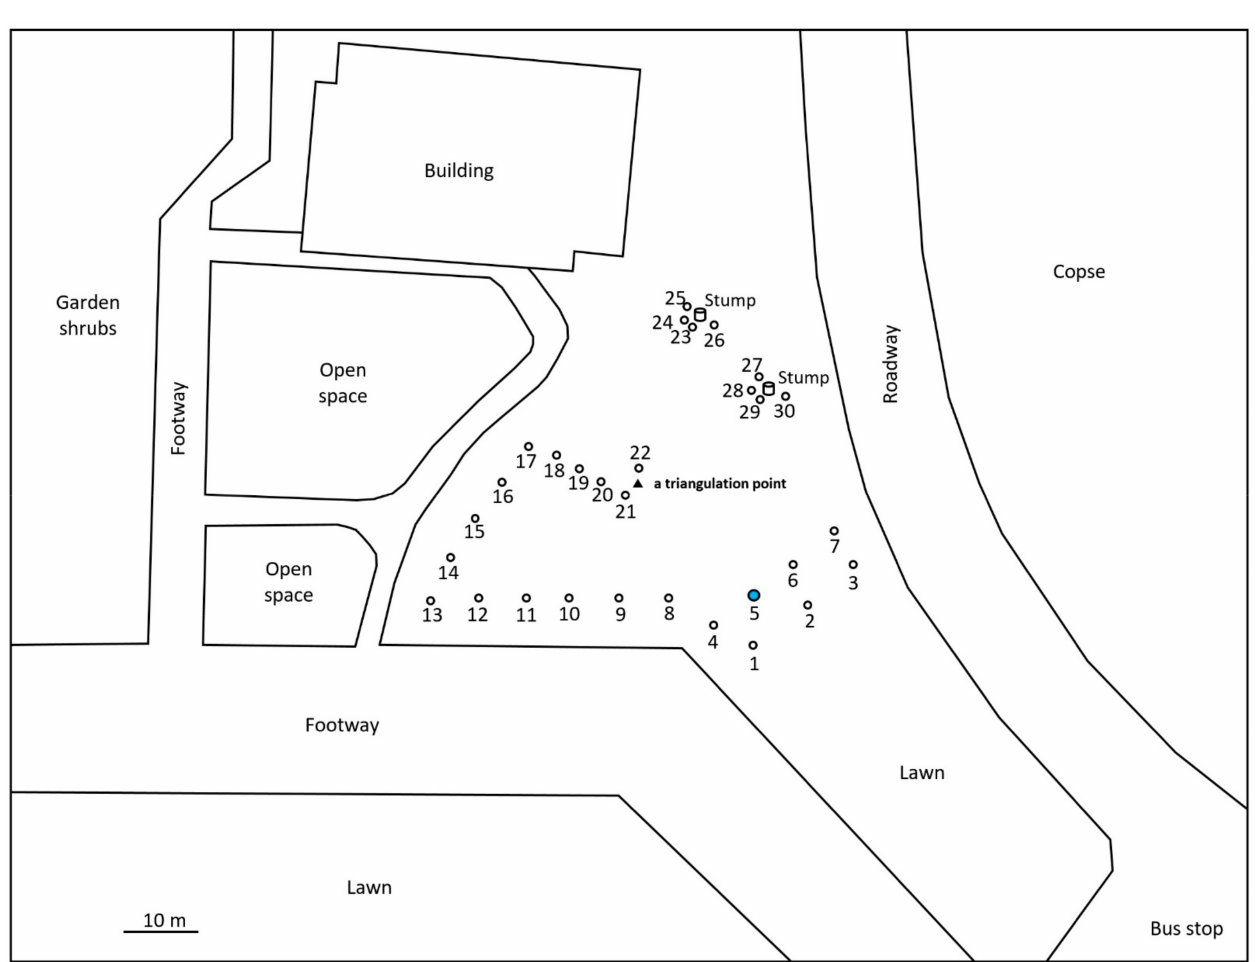
Figure 3. Location of monitoring stations (open circles) at Kindai University. All stations were installed in-ground in June 2013. Stations 1–7 were installed in flat ground. Stations 8–17 and 18–22 were set up at the foot of a hill and along the path, respectively. Stations 23–26 and 27–30 were installed around the stumps. Station 5, around which discontinuous soil treatment was carried out, is highlighted in